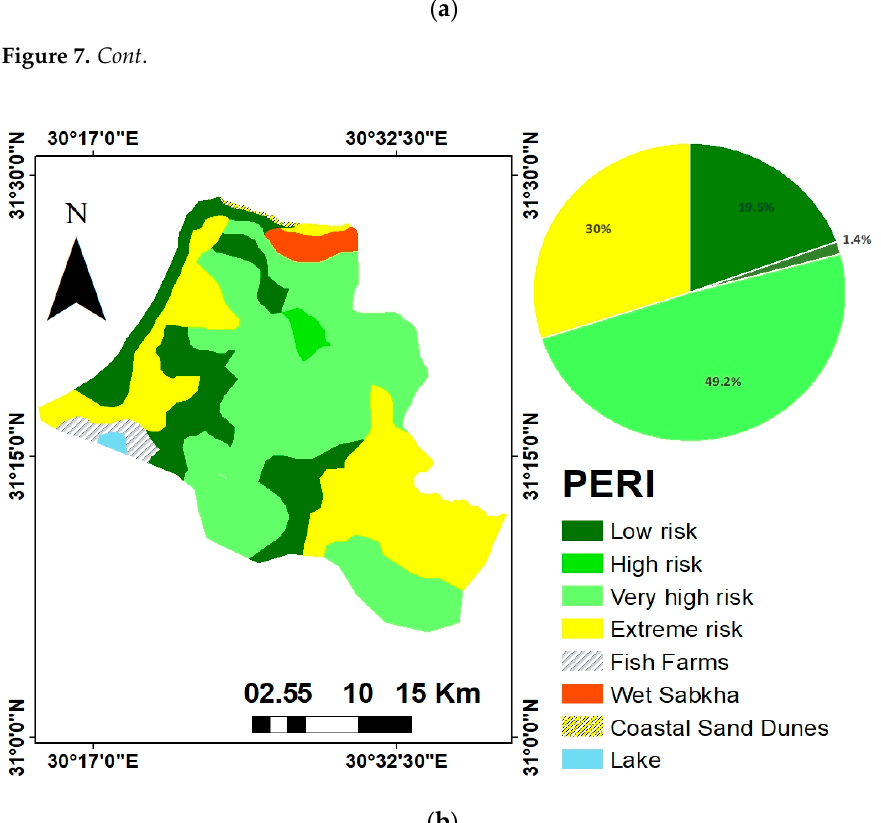
Figure 7. The contamination hazard indices maps of the study area ( a ) Improved Nemerow’s Pollution Index (Pn), and ( b ) Potential Ecological Risk Index (PERI).